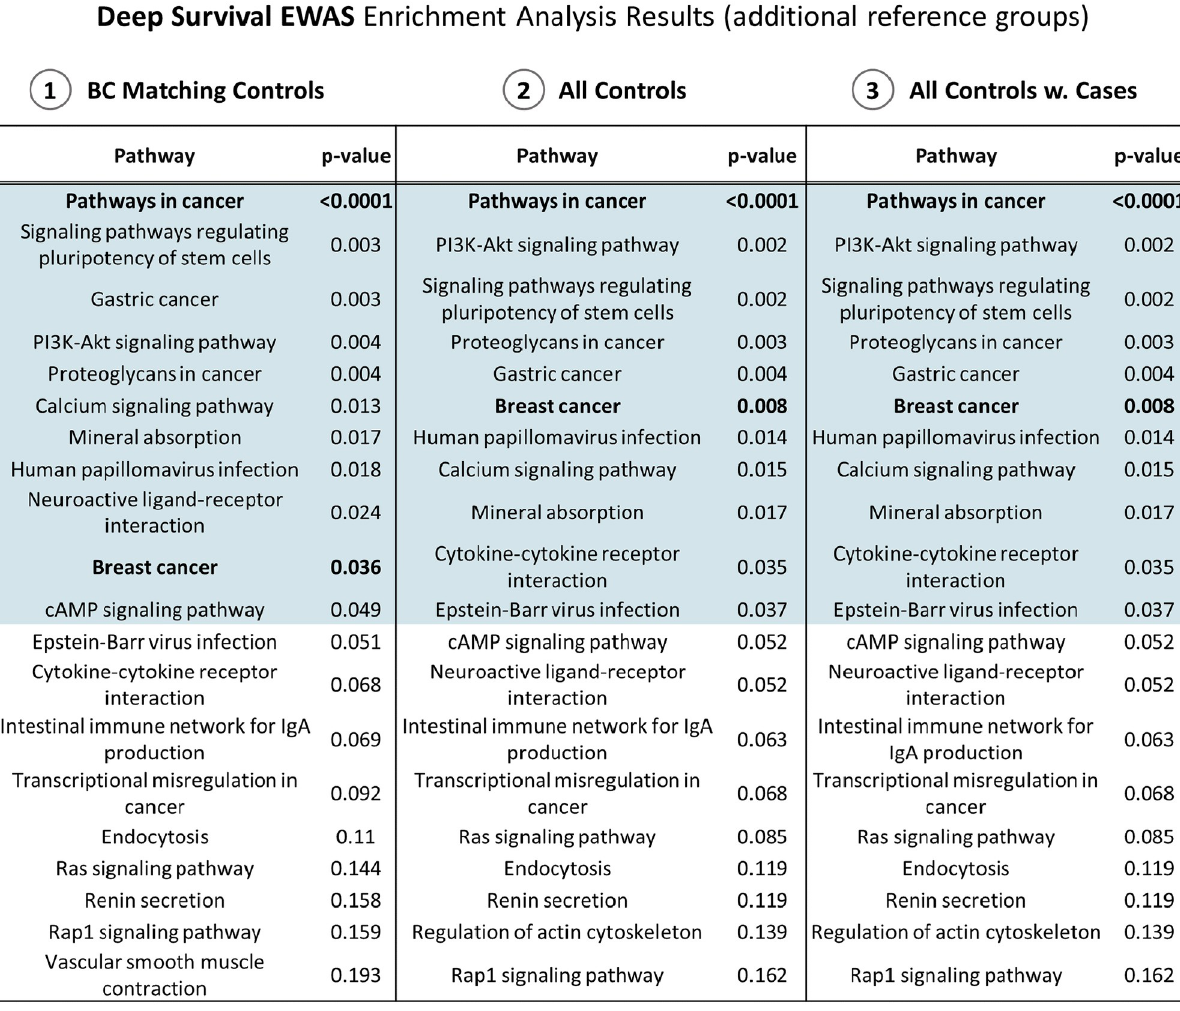
Fig 5. Weighted enrichment analysis results from Deep Survival EWAS (additional reference groups). In blue are highlighted the pathways with significant association, i.e. empirical p-value based on 10,000 permutations.